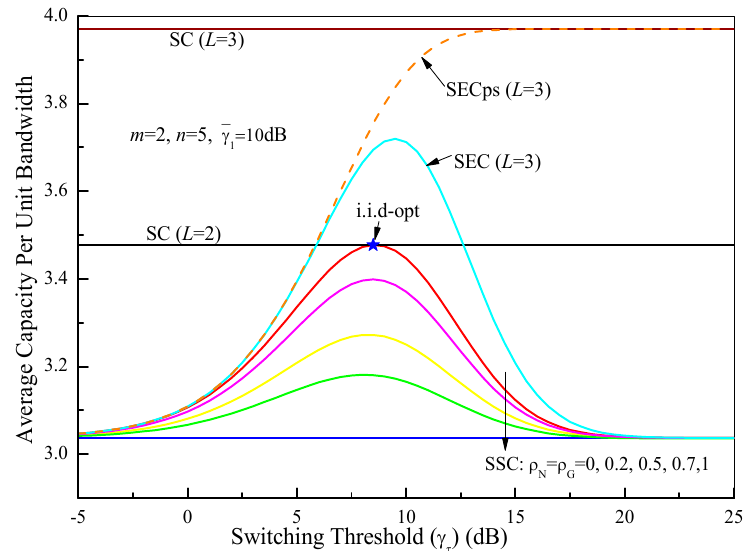
Figure 11. Comparison of the average capacity levels of different switched diversity systems as a function of the switching threshold ( γ τ ) over Fisher–Snedecor F fading channels with m = 2, n = 5, and 𝛾̅ (cid:2869) = 10 dB.